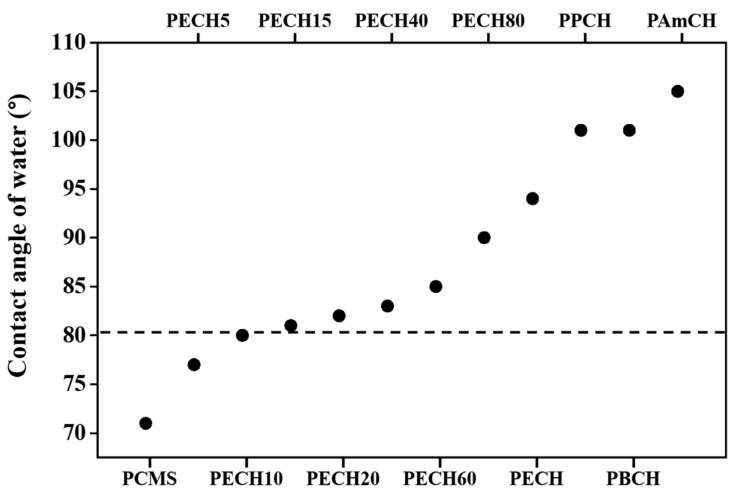
Figure 6. Water contact angle values and LC behaviors of polymer films. The upper part and lower part around the dashed line indicate vertical and planar LC orientation behaviors, respectively.